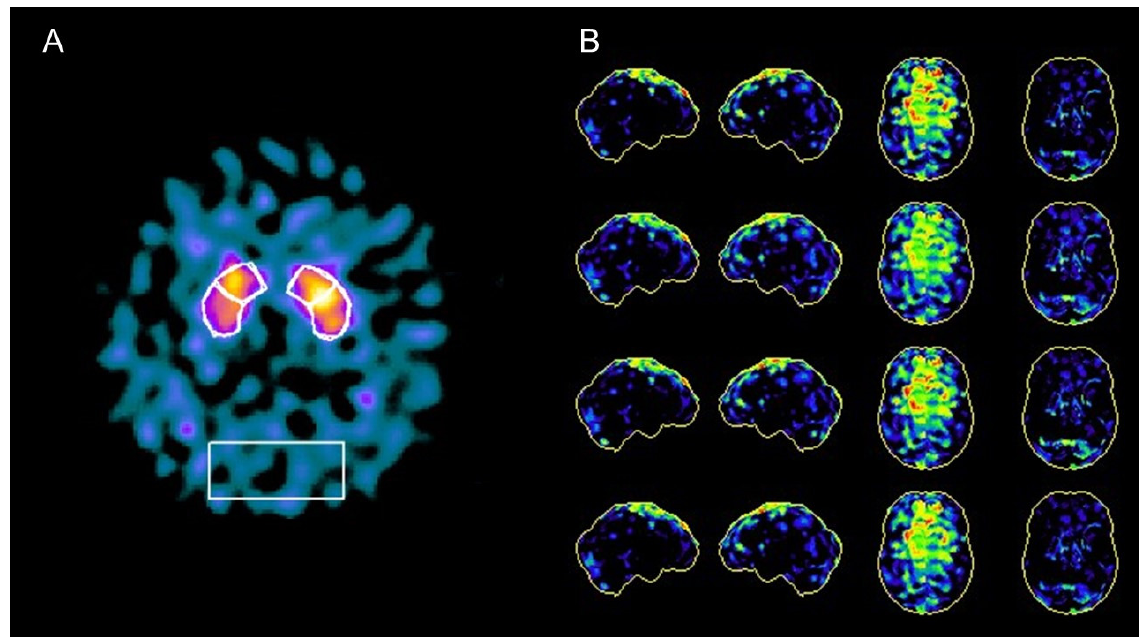
Figure 2. Nuclear imaging findings in a case of anti-IgLON5 disease : ( A ) [123I] FP-CIT SPECT showed dopaminergic nigrostriatal denervation, more prominent in the right putamen; ( B ) brain perfusion SPECT imaging documented relative hyperperfusion in the high-convexity area with relative preservation of other brain regions.